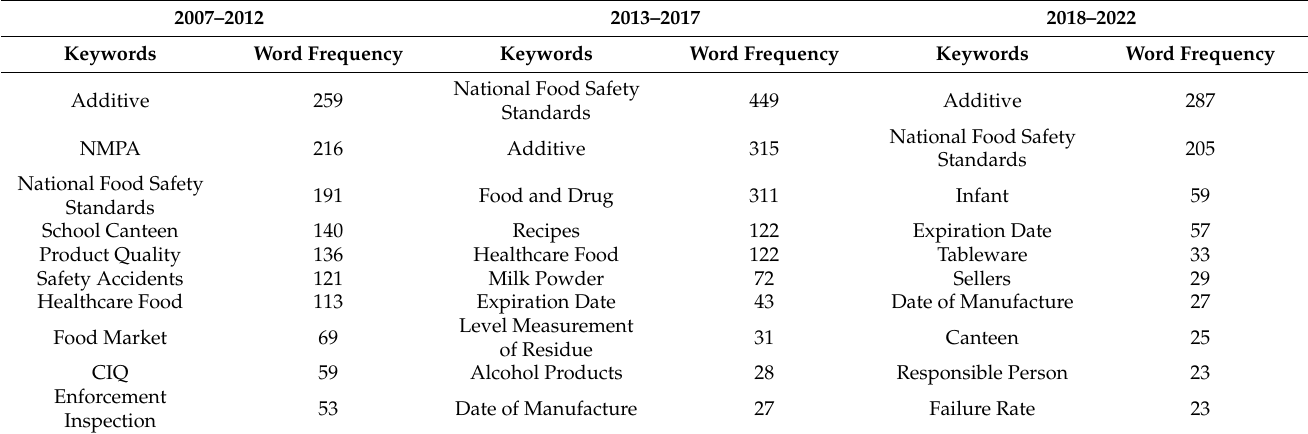
Table 1. Annual keywords of national food safety policy.